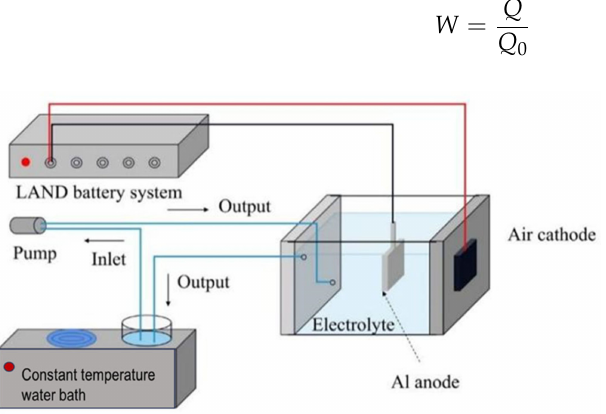
Figure 2. Schematic diagram of the Al-air battery discharge test